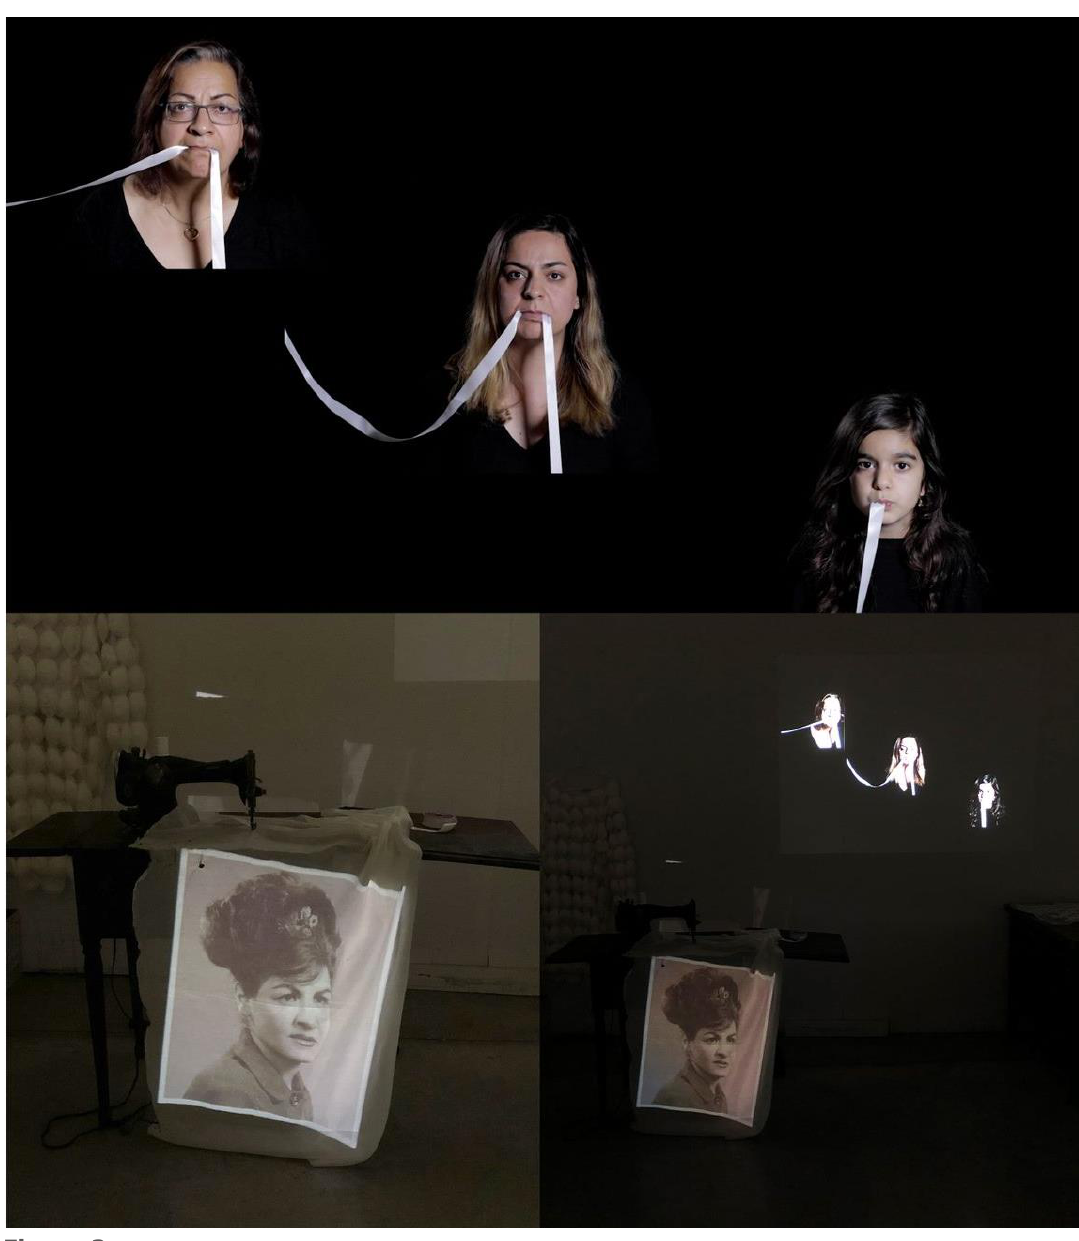
Sepideh Tajalizadeh Dashti, Generations, 2019. Installation (one channel video, projected photograph, sewing machine,